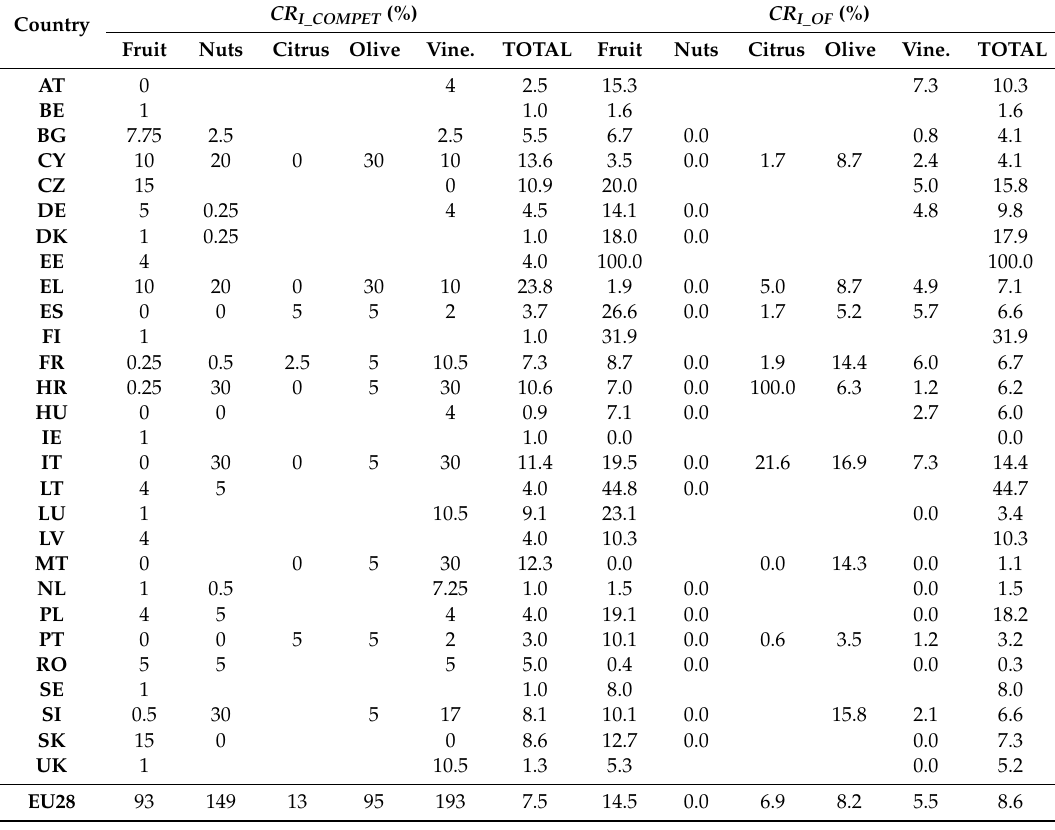
Table 4. CR implementation potentials averaged by country: competitiveness and organic farming. CR I_COMPET (%) CR I_OF (%) Country Fruit Nuts Citrus Olive Vine. TOTAL Fruit Nuts Citrus Olive